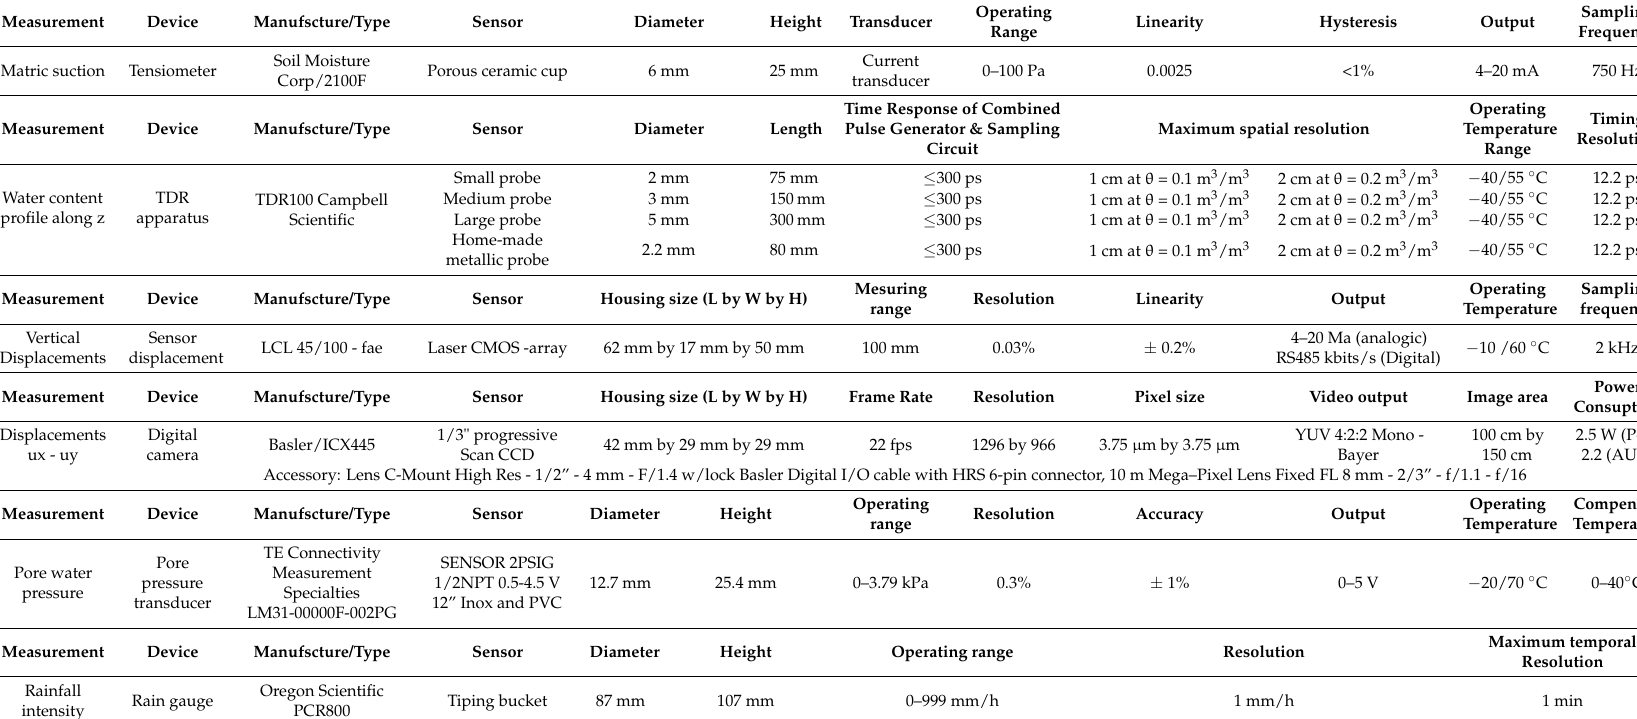
Table 1. Main characteristics of